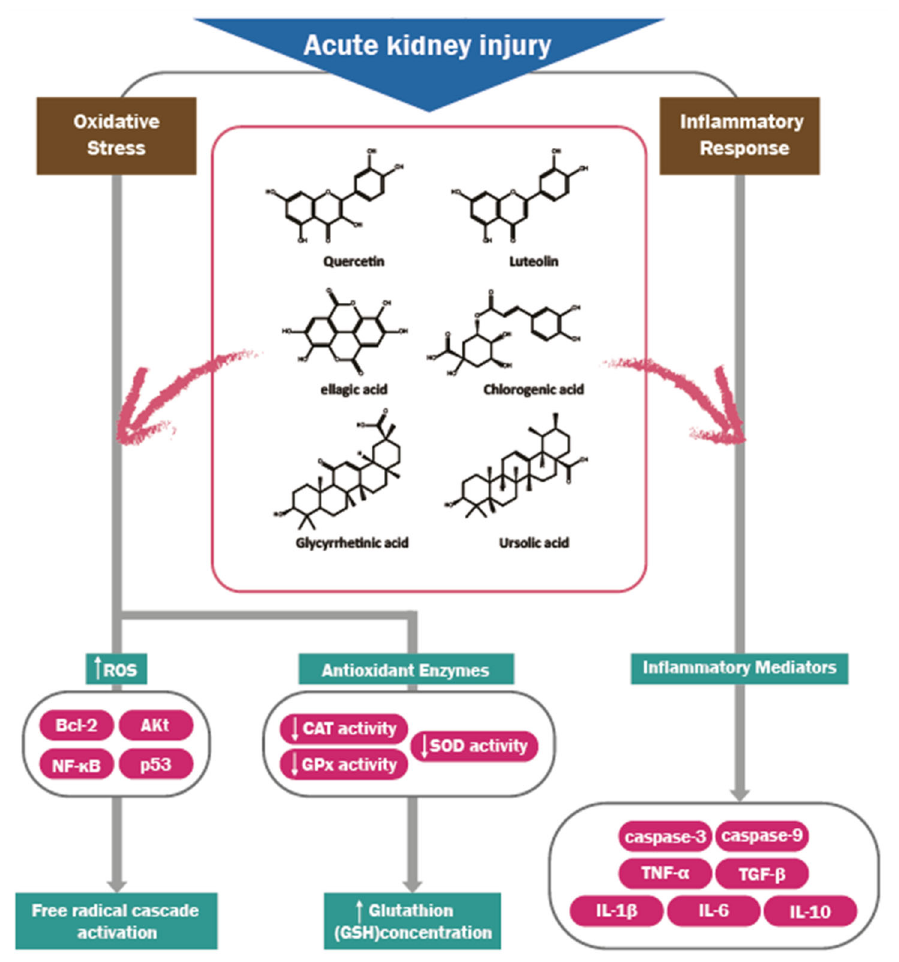
Figure 1. Oxidative stress and inflammatory response mechanisms involved in the pathogenesis of aucte kidney injury and some effect compounds. Abbreviation ROS; Reactive oxygen species, CAT; catalase, GPX; Glutathione peroxidase.